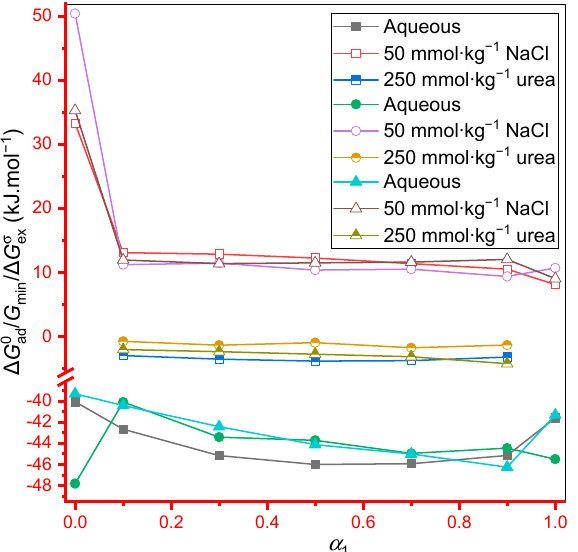
Figure 2. Variation of ∆𝐺 (cid:2911)(cid:2914)(cid:2925) / G min /Δ𝐺 ex (cid:3097) value with change in mole fraction ( α 1 ) of TX-100 in different media (filled, open, and half-filled symbols represent ∆𝐺 (cid:2911)(cid:2914)(cid:2925) , G min , and Δ𝐺 ex (cid:3097) respectively).